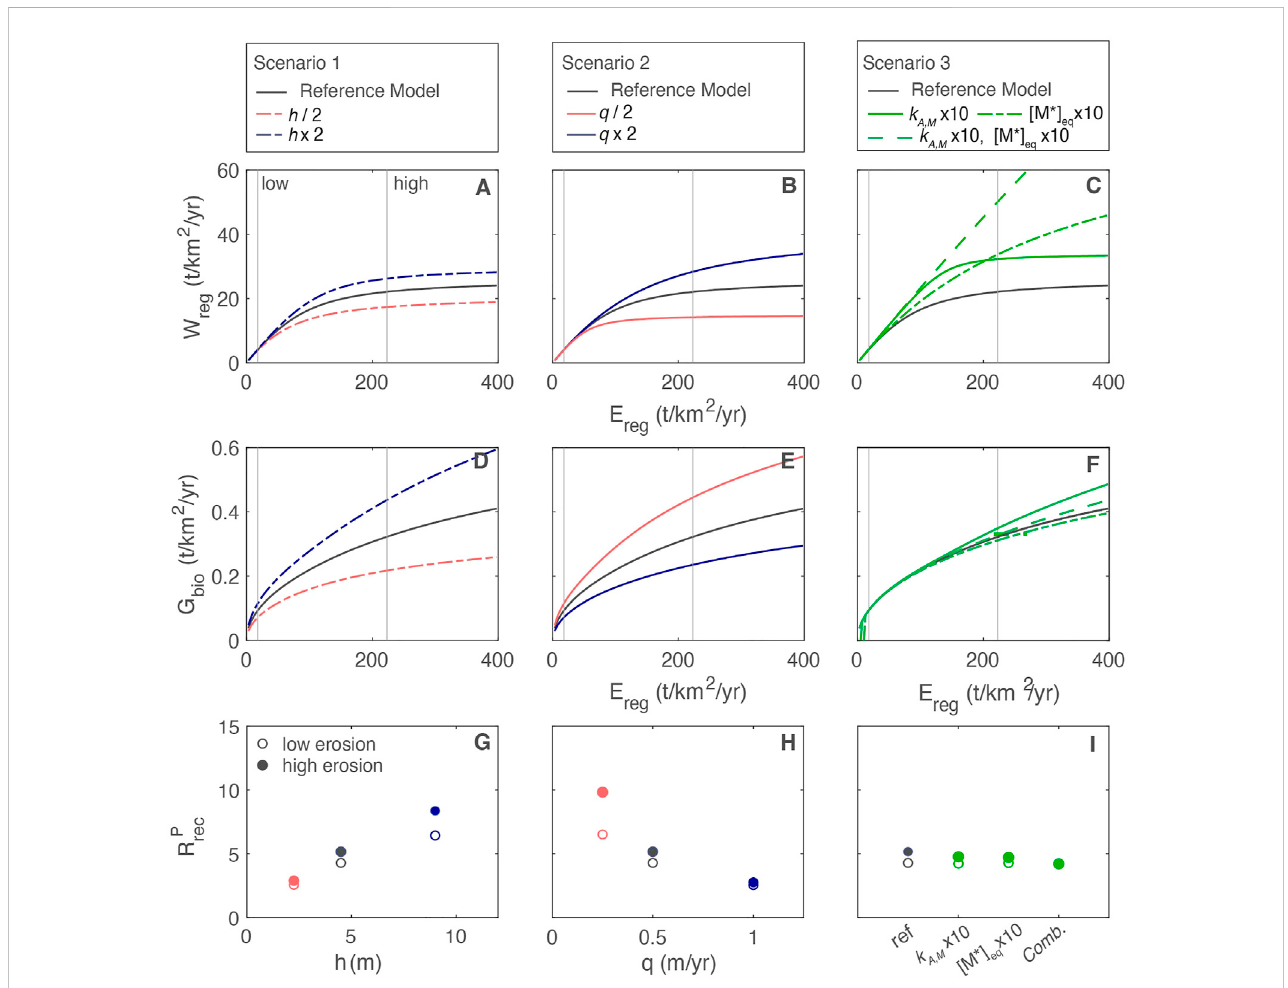
FIGURE 9 (A – C) Chemical weathering export W M * reg for scenarios 1-3, respectively. The low erosion rate (18 t/km 2 /yr) corresponds to the 50th percentile of erosion rates, high erosion rate (223 t/km 2 /yr) corresponds to the 90th percentile (Milliman and Syvitski, 1992). (D – F) Growth rate ( G C bio ) for scenarios 1 – 3. (G – I) R P rec relative to reference model for scenarios 1-3 with values taken for the low and high erosion rates indicated